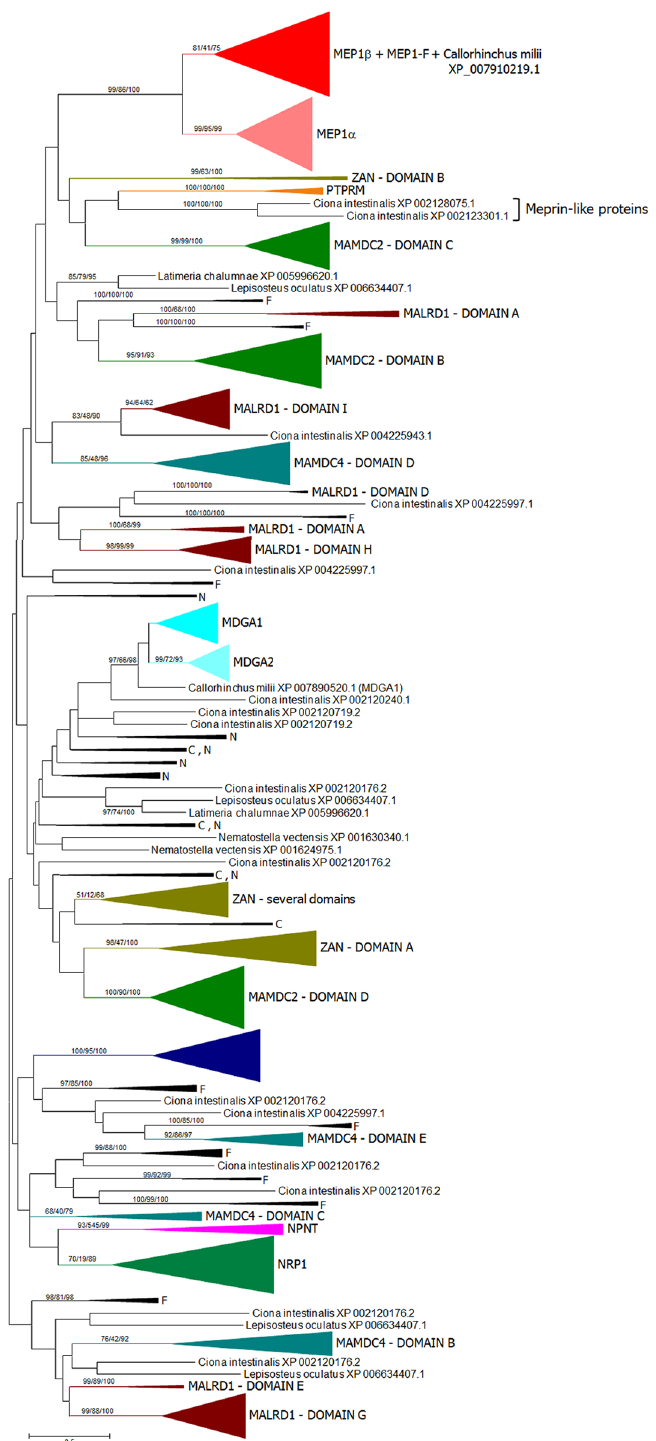
Fig 6. ML tree based on 1470 selected MAM domain sequences. Numbers again refer to bootstrap support (1000 replicates for the NJ analysis; 100 for MP and ML analyses). Alternative colors have been used for different proteins. When more than one MAM domain were present in a given protein, they were named with a capital letter (A, B, C etc.), assigned by moving from the N towards the C terminus of the protein. Thus, “ ZAN — domain B ” refers to the second MAM domain found counting from the N-terminus of the ZAN